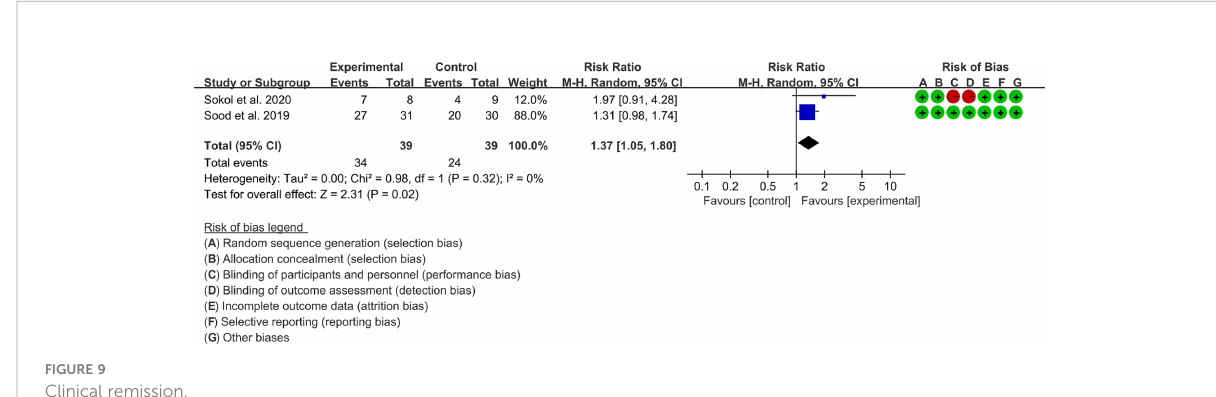
FIGURE 9 Clinical remission.